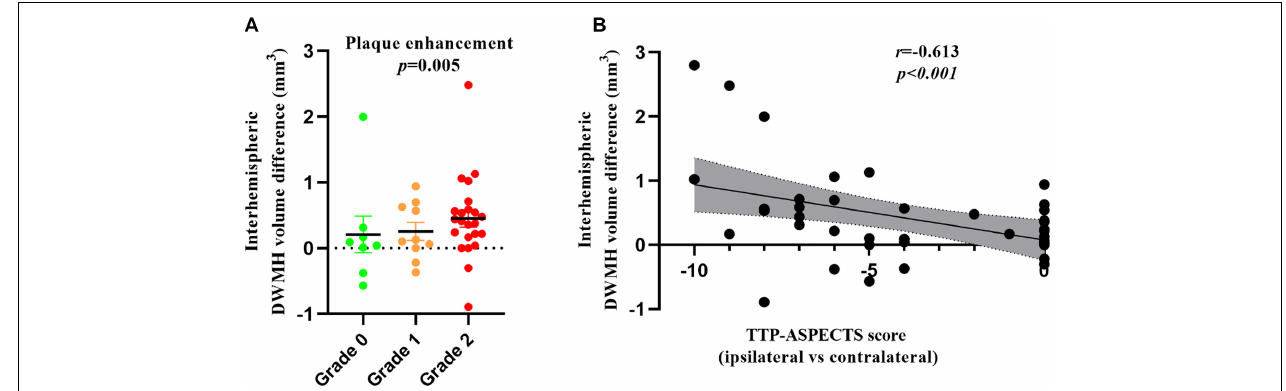
FIGURE 2 | Bar graphs showing the inter-hemispheric DWMH volume difference among patients with different plaque enhancement grades (A) . Scatter plots showing the relationship between TTP-ASPECTS and the inter-hemispheric DWMH volume difference (B) . WMH volume was log-transformed to normalize the